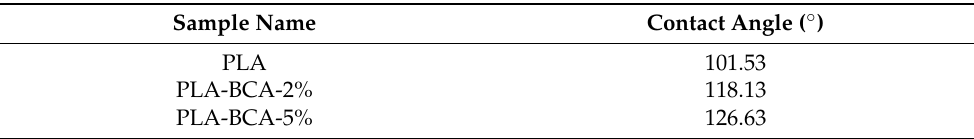
Table 3. Contact angle of electrospun PLA fibers with and without biochanin A.